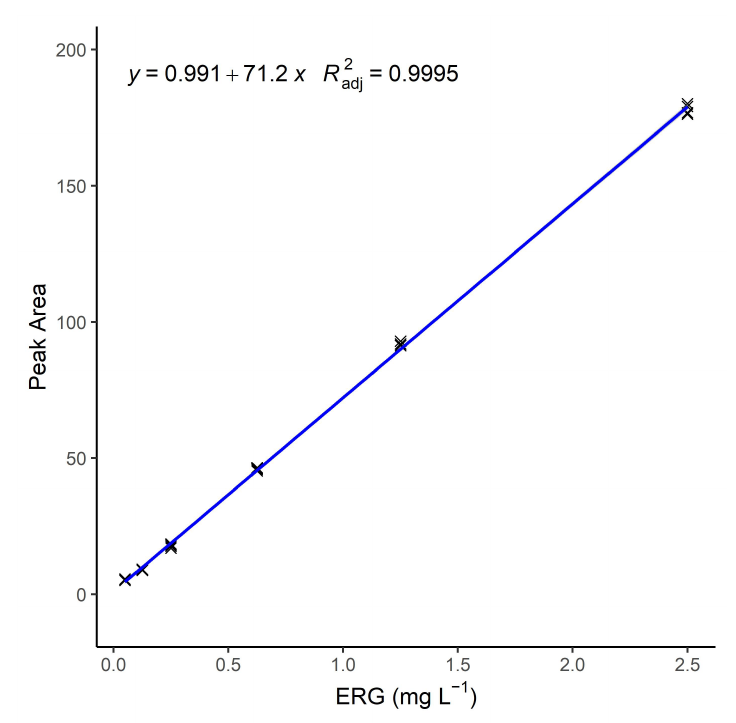
Figure A1. Calibration curve for